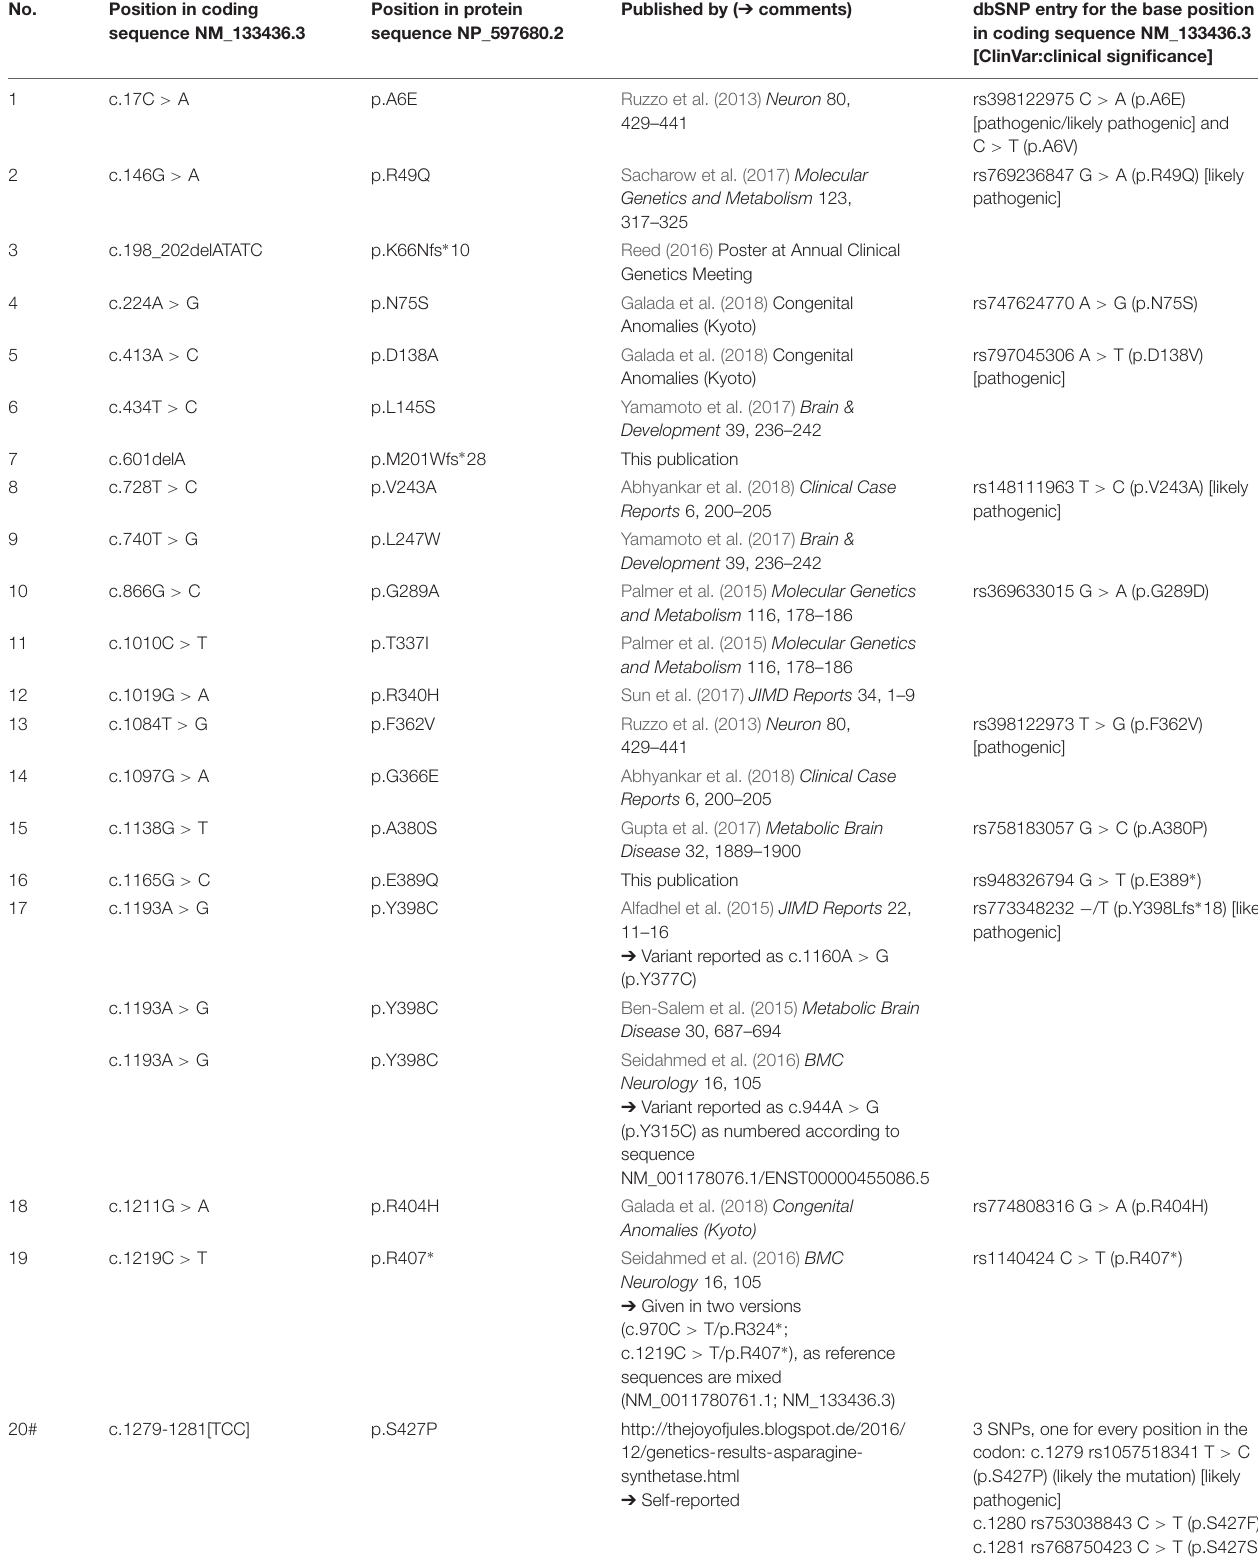
TABLE 1 | New and published ASNS genetic variants associated with microcephaly. No. Position in coding sequence